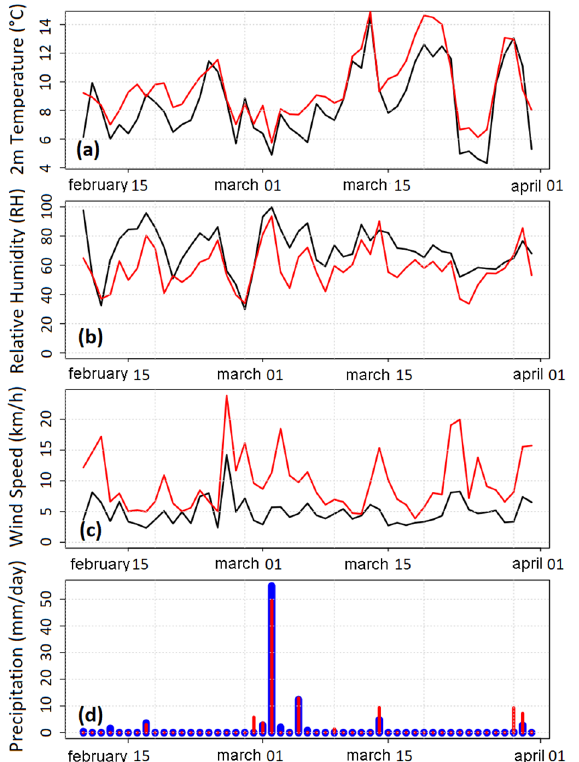
Figure 6. The 2m temperature (°C) ( a ), relative humidity (%) ( b ), wind speed (km/h) ( c ), and cumulative daily precipitation (mm) ( d ) in the city of Milan for the period 10 February–31 March 2020. Simulated variables with the WRF model are represented by red, and the observations are represented by black and blue (for precipitation).